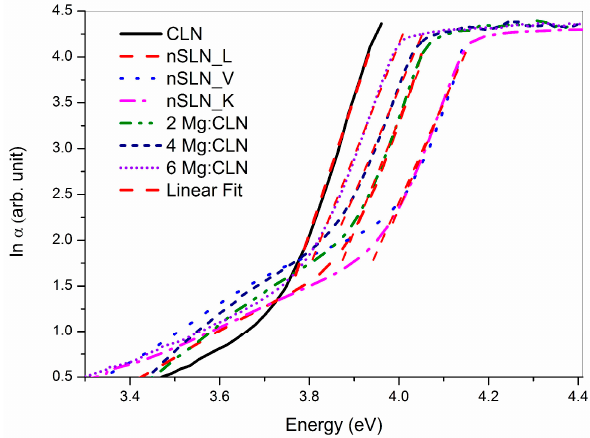
Figure 10. The dependence of ln α with incident photon energy.